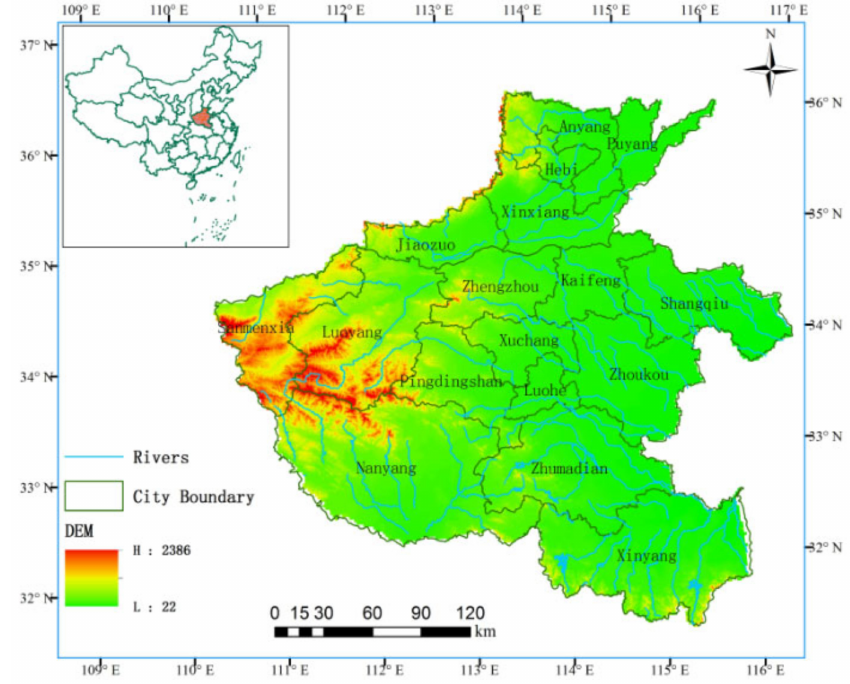
Figure 2. Schematic diagram of the location of Henan Province in Central China.